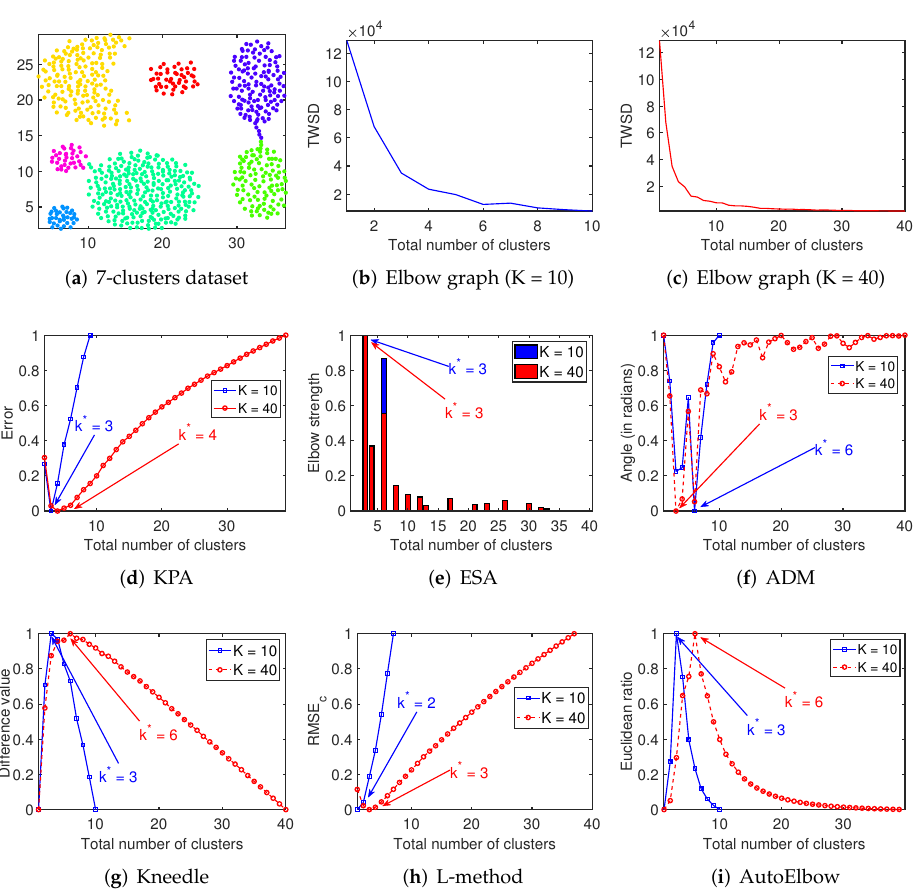
Figure 4. Medium cluster number case study: seven